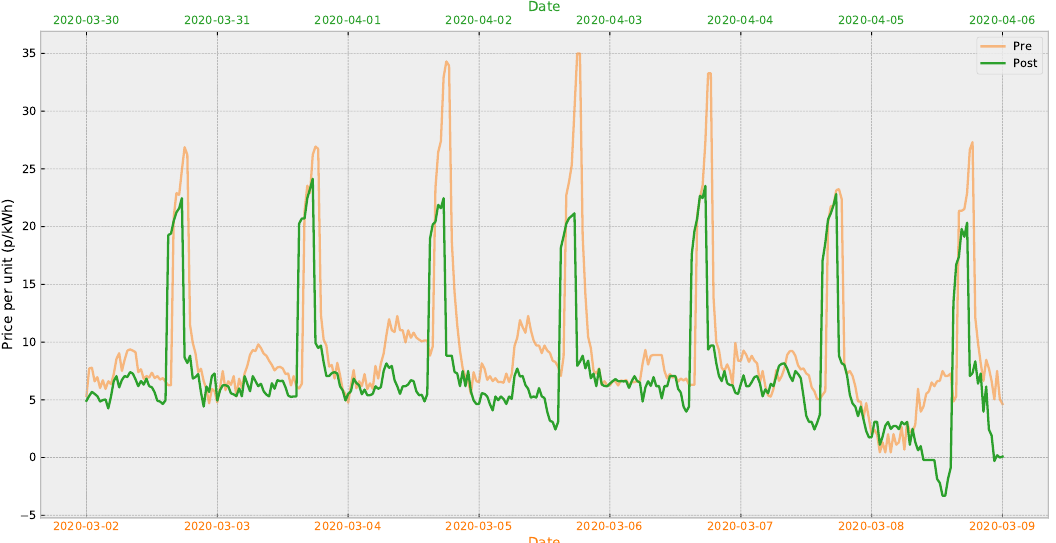
Figure 18. Examples of price capping (5 March 2020 on the lower orange x-axis) and negative pricing (5 April 2020 on the higher green x-axis) during pre- and post-lockdown weeks, respectively, using the data from [37].